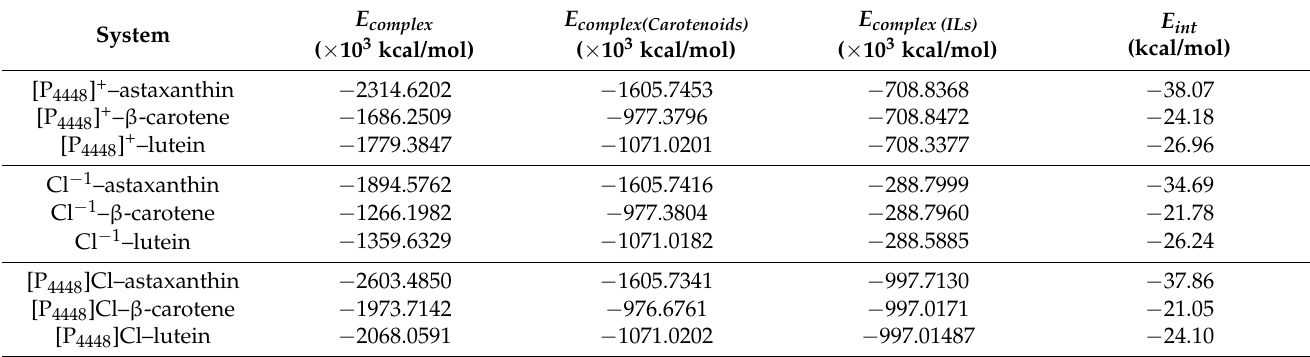
Table 2. Interaction energies ( E int ) between [P 4448 ] + , Cl − 1 , and [P 4448 ]Cl with carotenoids. E complex represents the energy of the complex. E complex(Carotenoids) and E complex (ILs) represent the energy of carotenoids (astaxanthin, β -carotene, and lutein) molecules and ionic liquids ([P 4448 ] + , Cl − 1 , and [P 4448 ]Cl) molecules,